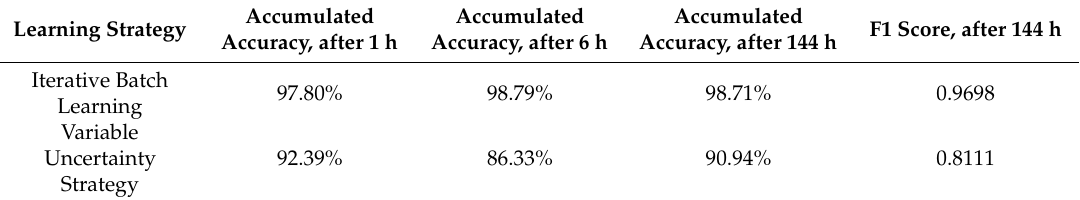
Table 1. The accumulated accuracy and F1-score for learning strategies in static settings.